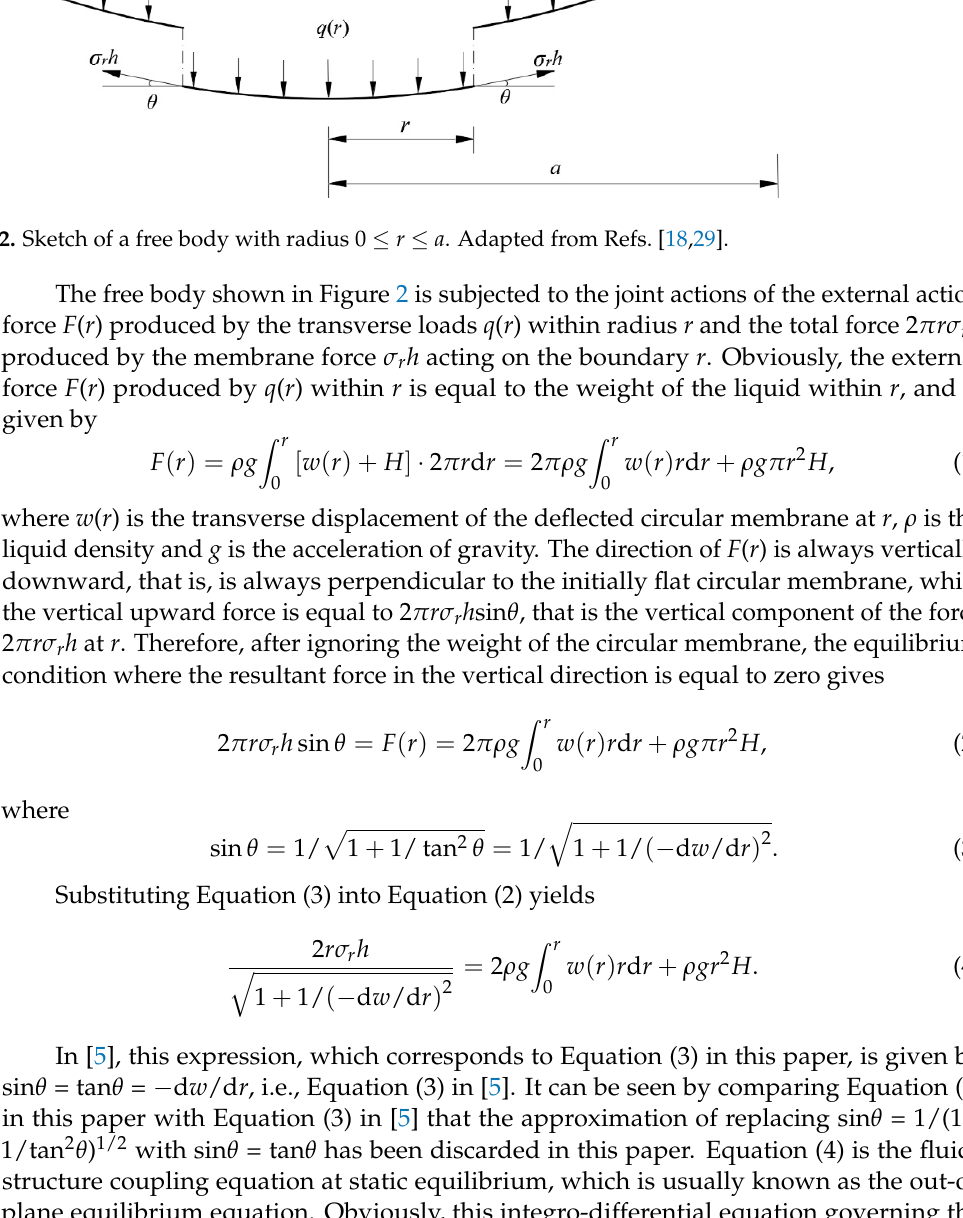
membrane, θ denotes the rotation angle of the deflected circular membrane, σ r denotes the radial stress, and q ( r ) denotes the transverse loads that varies continuously with the radial coordinate r (i.e., the liquid acting on the surface of the deflected circular membrane, which is distributed uniformly in the circumferential direction and unevenly in the radial direction and can thus be represented as a function of the r ).